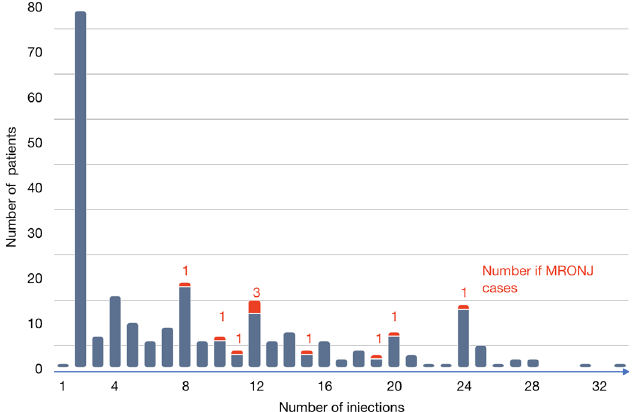
Fig. 2. Number of cases of MRONJ in function of denosumab exposure duration (number of injections).